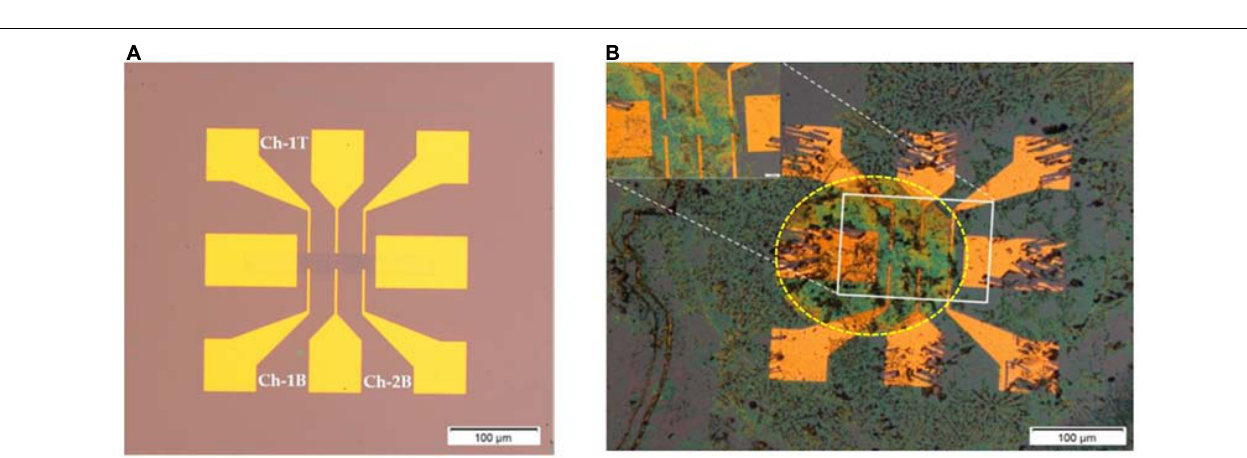
FIGURE 2 | Graphene field effect transistor (GFET) device; (A) symmetric GFET device with graphene channel length of 400 µ m (symmetry by 3 voltage leads above and below the graphene channel). Here Ch-1T refers to channel 1 top voltage leads, Ch-lB refers to channel 1 bottom voltage leads and Ch-2B refers to channel 2 bottom voltage leads; (B) GFET device with antibody bound Clusterin (at 1 pg/mL concentration), inset shows closer view of graphene channel and yellow dotted lines indicate the drop of solutions on the two series GFET channels (diameter of the drop region is ∼ 900 µ